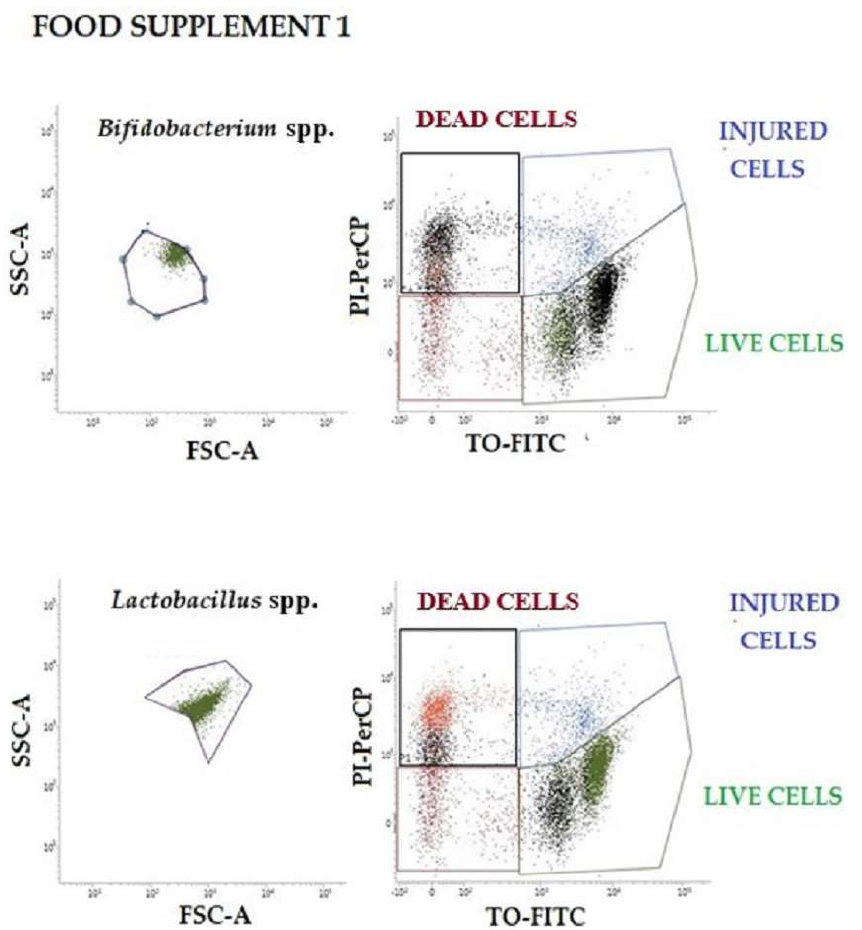
Figure 2. Representative dot-plots of food supplement 1 were analyzed by flow cytometry. Two different graphs are shown for both Bifidobacterium spp. and Lactobacillus spp.: one represents the morphological features of each population, while the other on the right represents bacteria vitality, (red dots are dead cells; blue dots are injured cells; green dots are live cells). SSC-A: Side Scatter-Area; FSC-A: Forward Scatter-Area; PI-PerCP: Propidium Iodide-Peridinin-Chlorophyll-Protein; TO-FITC: Thiazole Orange-Fluorescein isothiocyanate.